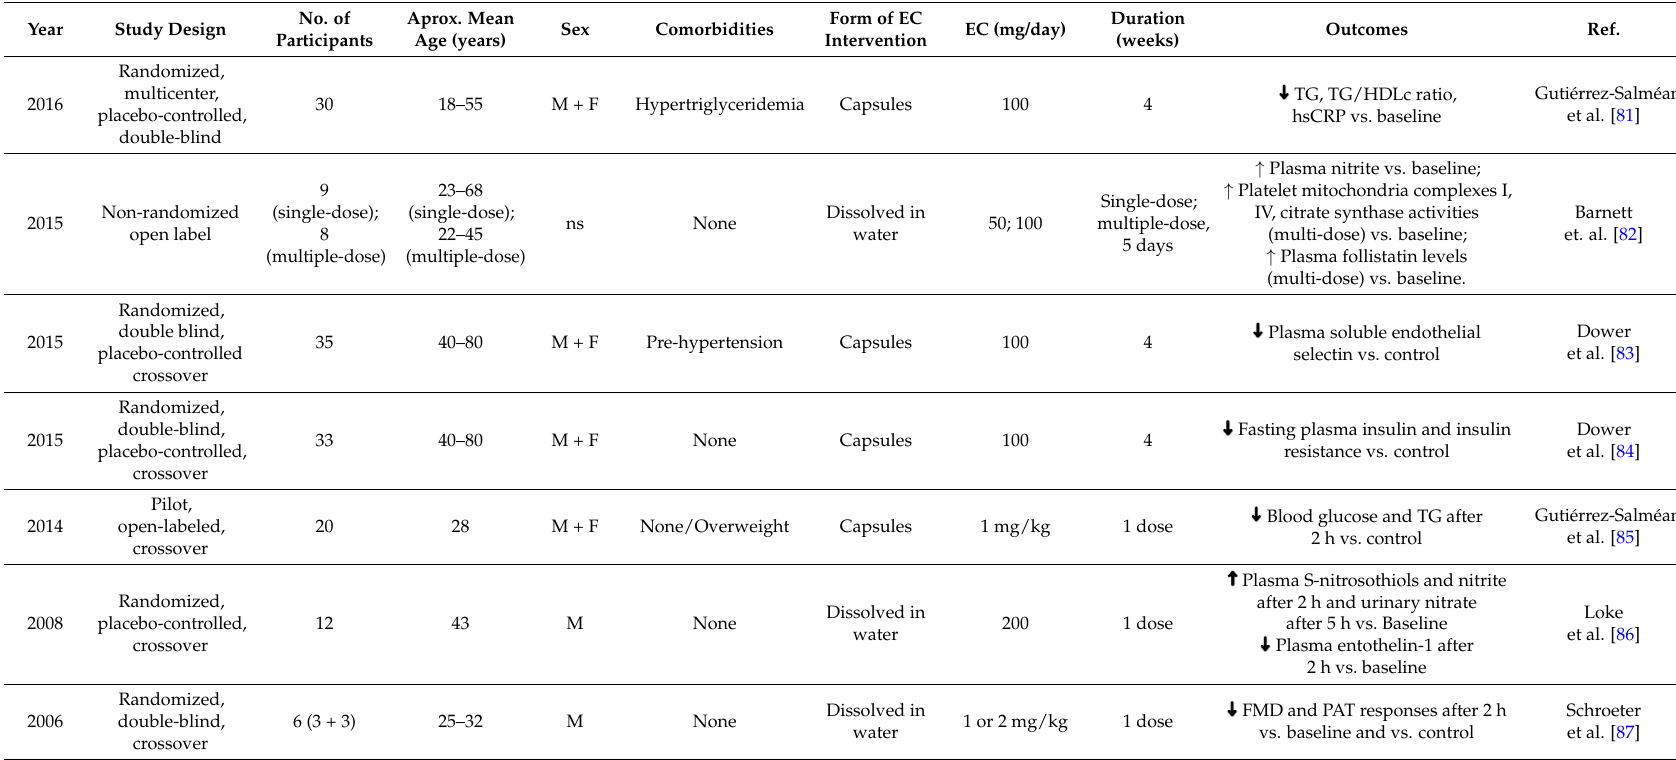
Table 2. Outcomes of clinical trials of epicatechin (2016–2006). Table 1. Outcomes of recent (2014–2016) clinical trials of cocoa products.